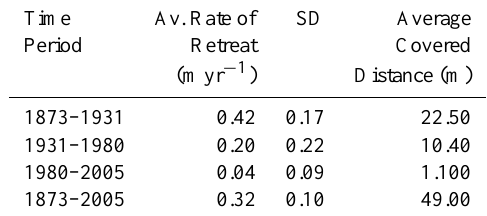
Table 3. Average retreat rates for different time